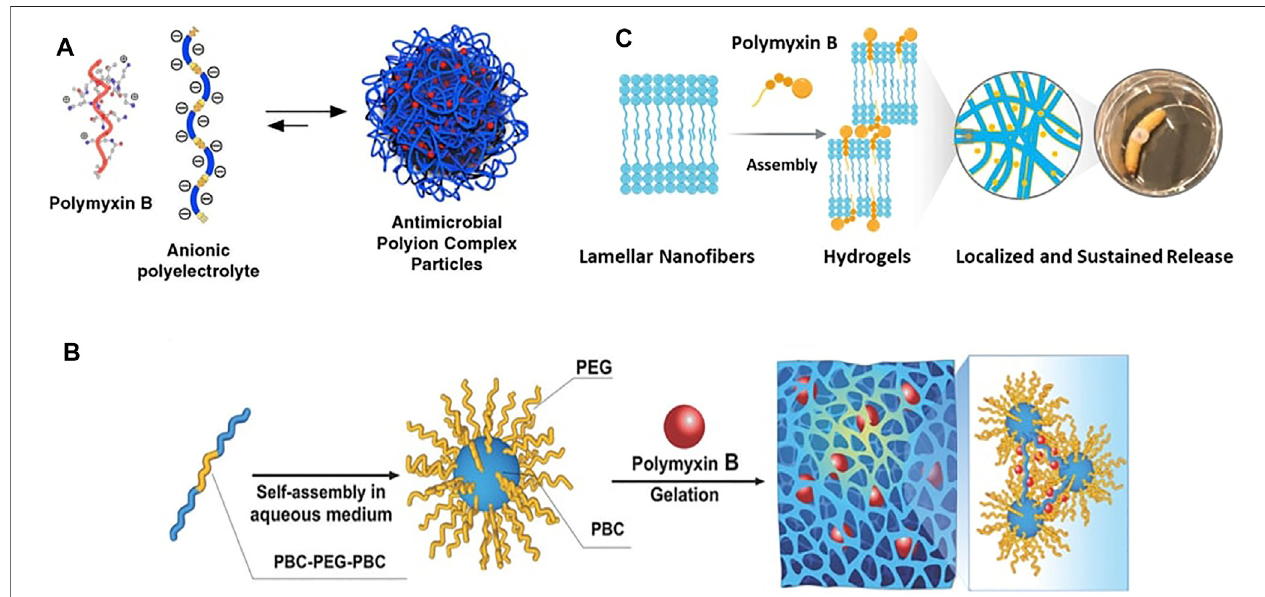
FIGURE 2 | The polymyxin B-based delivery systems: (A) Polyion complex nanoparticles co-assembled from polymyxin B with poly(styrene sulphonate). Reproduced from (Insua et al., 2017), published by Elsevier Ltd., (B) polymyxin B crosslinked hydrogels based on the core-shell micelles assembled from the phenylboronic acid functionalized polycarbonate and polyethylene glycol triblock copolymer (PBC-PEG-PBC). Adapted with permission from (Obuobi et al., 2018). Copyright 2018, Wiley-VCH GmbH, (C) polymyxin B crosslinked hydrogels based on the lamellar nano fi bers assembled from rationally designed peptide amphiphiles. Adapted from (Shi et al., 2021), published by Wiley-VCH GmbH.